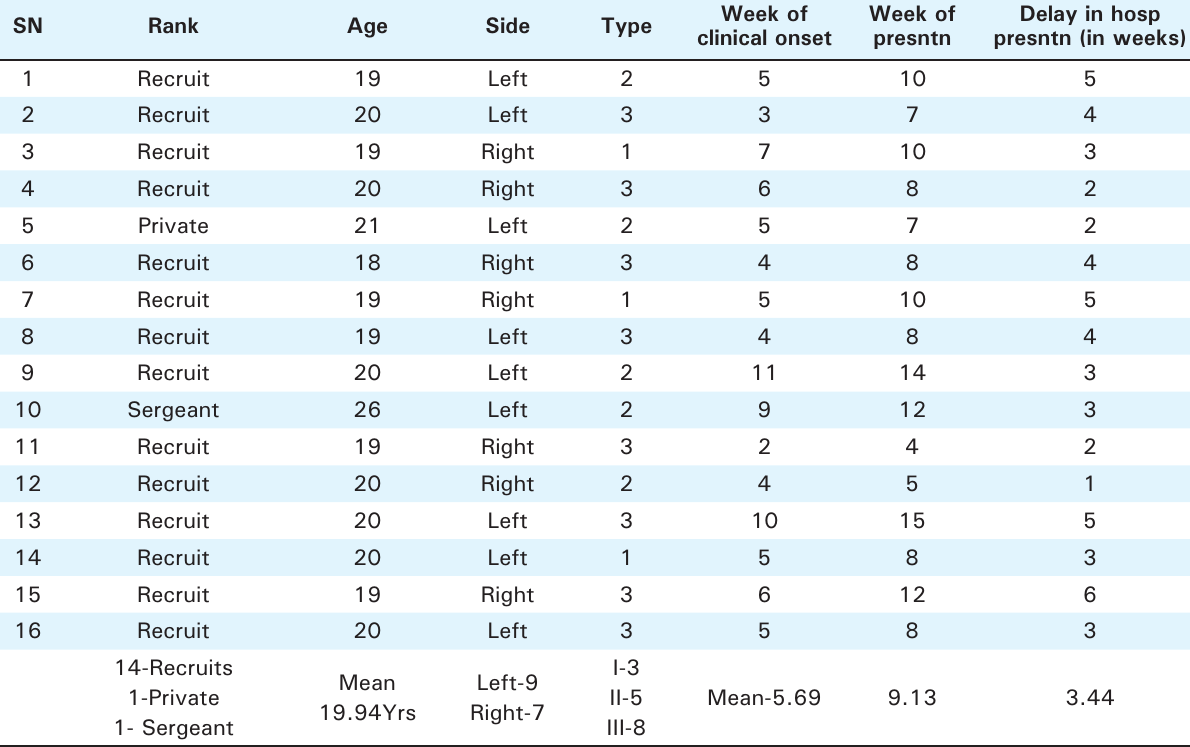
Table 1. Different parameters of the patients SN Rank Age Side Type